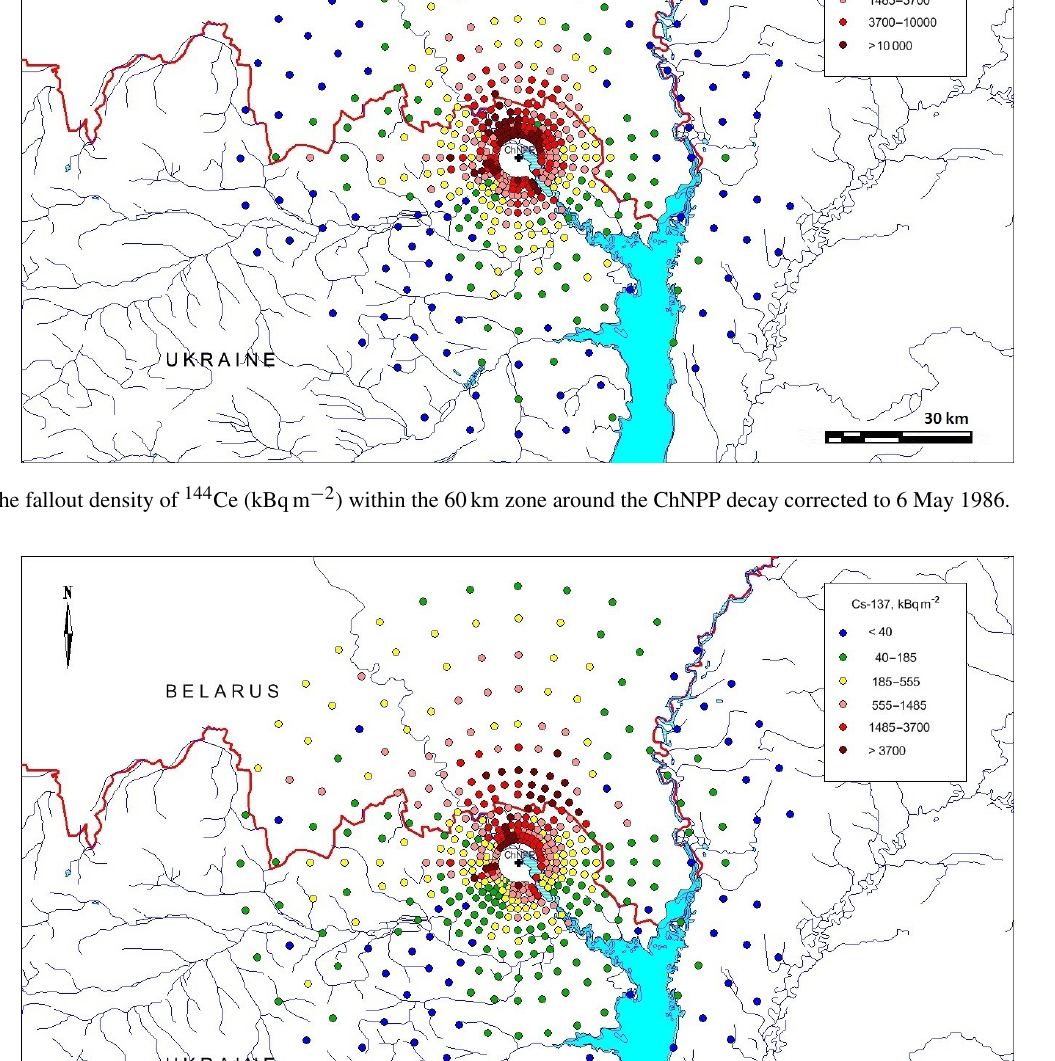
(EG&G, ORTEC, USA), was used in the gamma